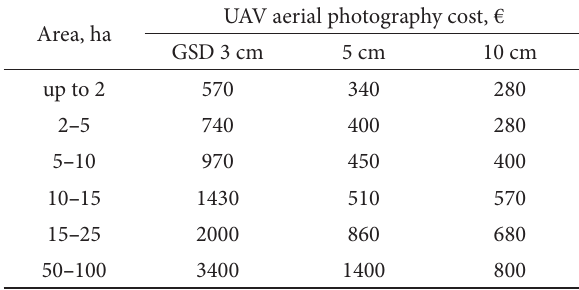
Table 4. Price-list for aerial